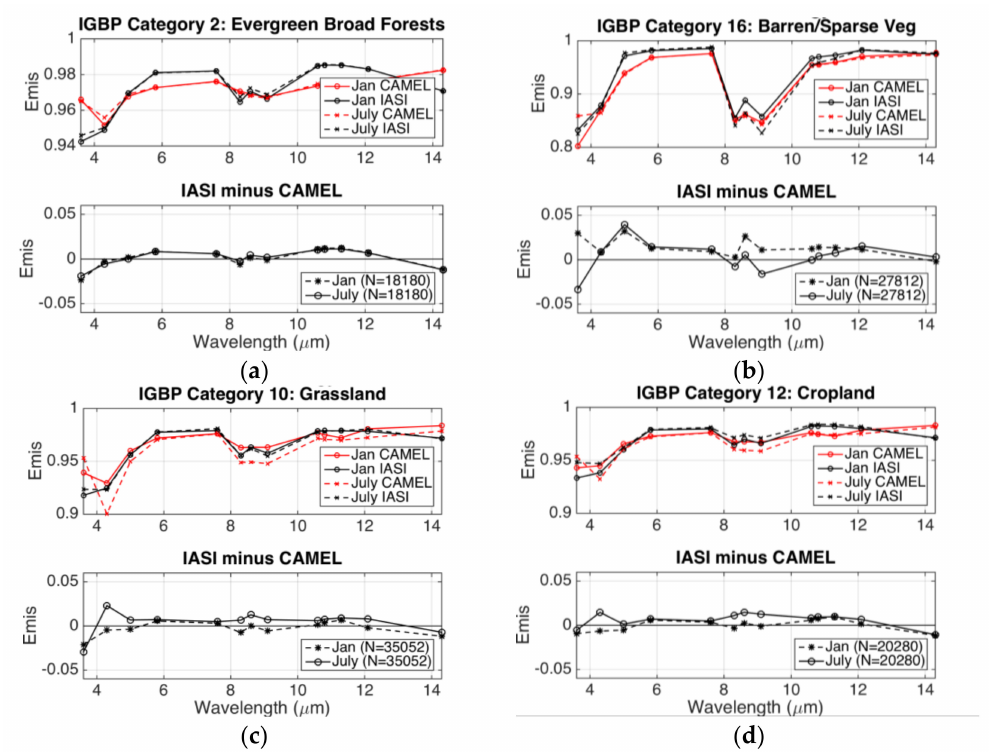
Figure 6. Top panels show IASI (black) and CAMEL (red) 8-year average emissivity averaged over the ( a ) evergreen broadleaf forest; ( b ) barren/sparse vegetation; ( c ) grassland; and ( d ) cropland IGBP land classifications for the months of January (solid line, circle markers) and July (red line, ‘X’ markers). Bottom panels show the associated averaged IASI minus CAMEL again for January (black dashed ‘X’ markers) and July (black solid circle markers). Number of samples, N, noted in bottom panel’s